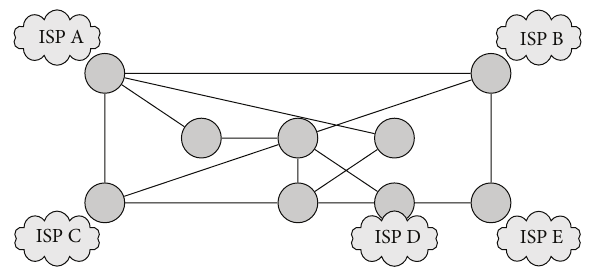
Figure 6: The interdomain network topology used in the simula-